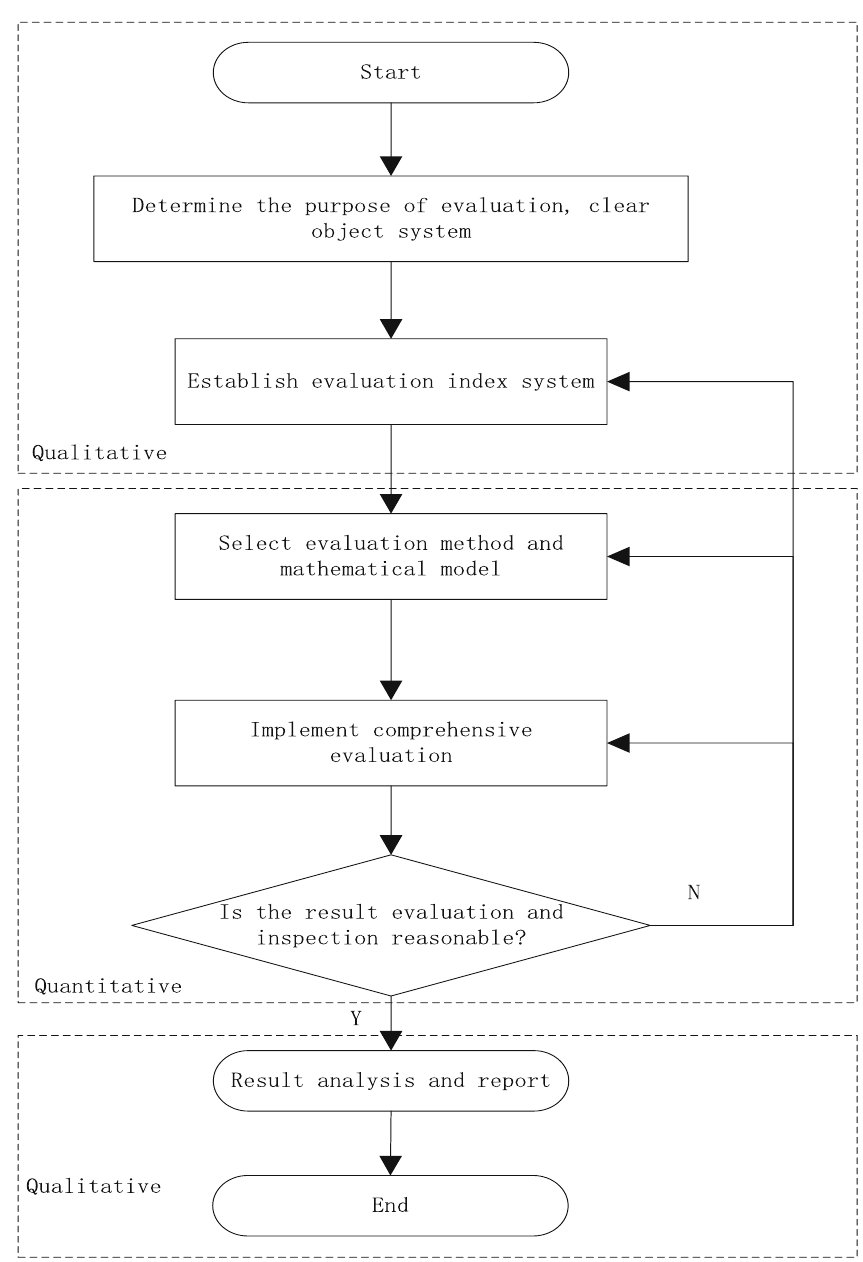
Figure 4: Flow chart of comprehensive